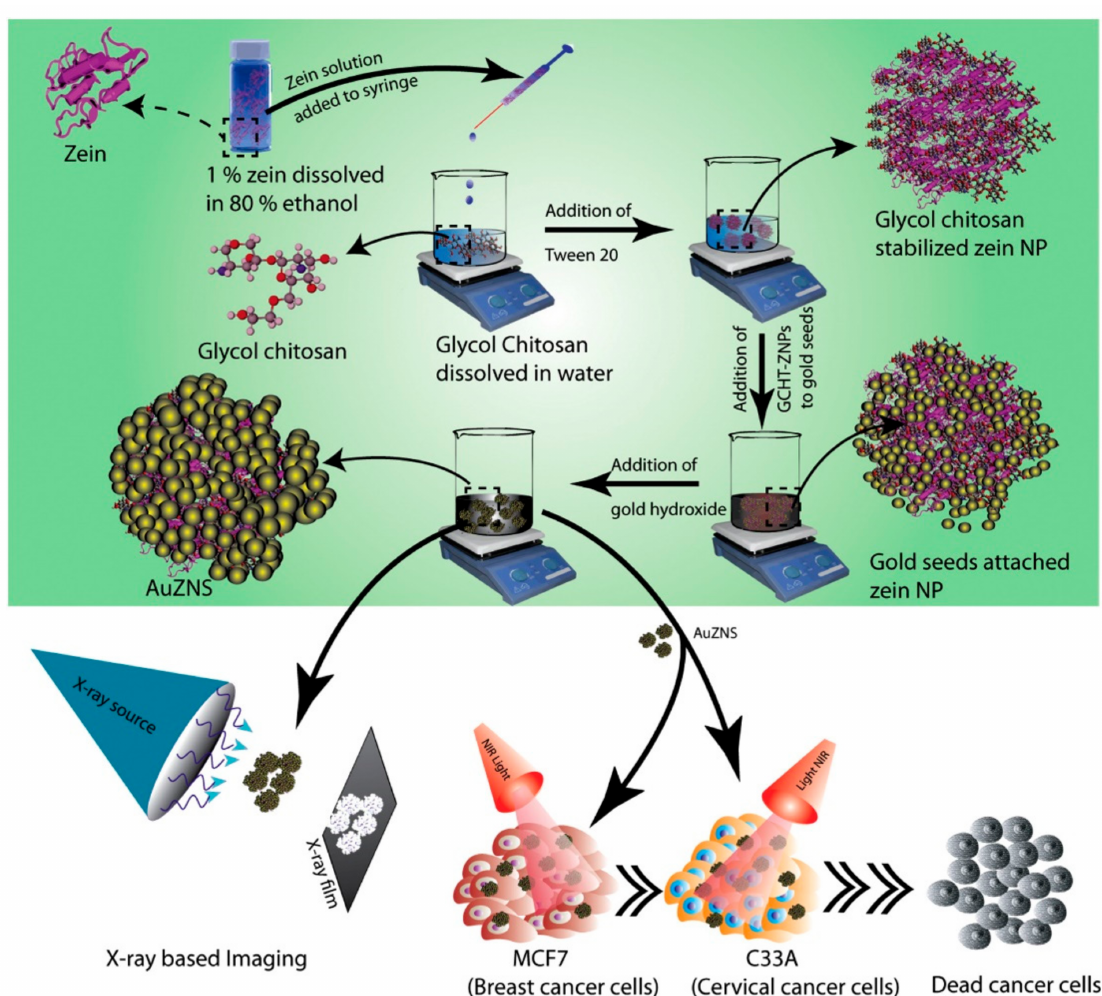
Figure 9. Process of preparing the zein-chitosan gold coated nanoparticles (nanoshells) (NP) for imaging and phototherapy applications. Reprinted with permission from ref. [70]. Copyright 2018